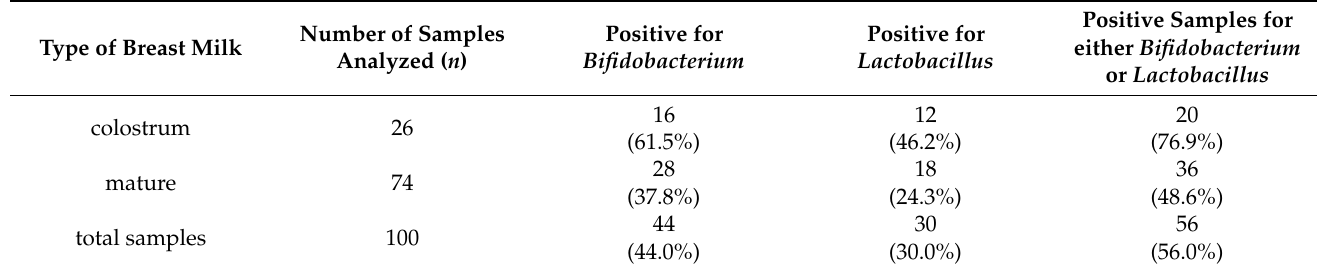
Table 2. Realtime PCR detection of probiotic bacteria Bifidobacterium and Lactobacillus in human breast milk.